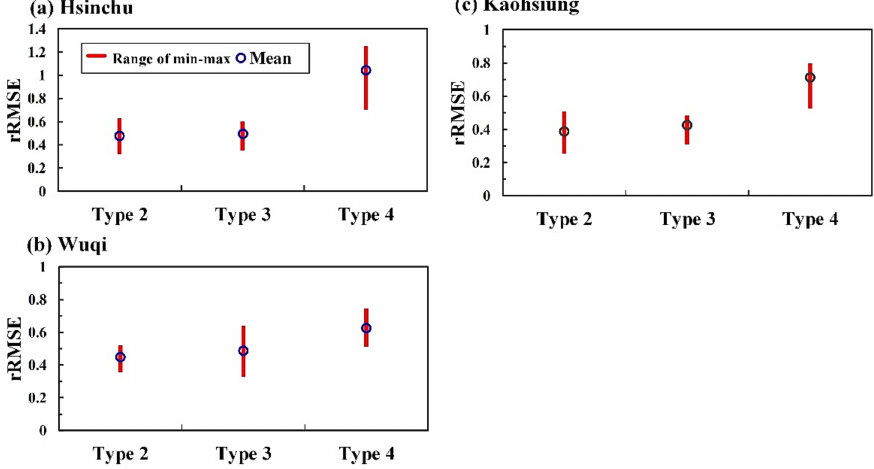
Figure 14. Range of min-max and mean values (lead time = 1–6 h) of relative root mean squared error (rRMSE) at ( a ) Hsinchu, ( b ) Wuqi, and ( c ) Kaohsiung